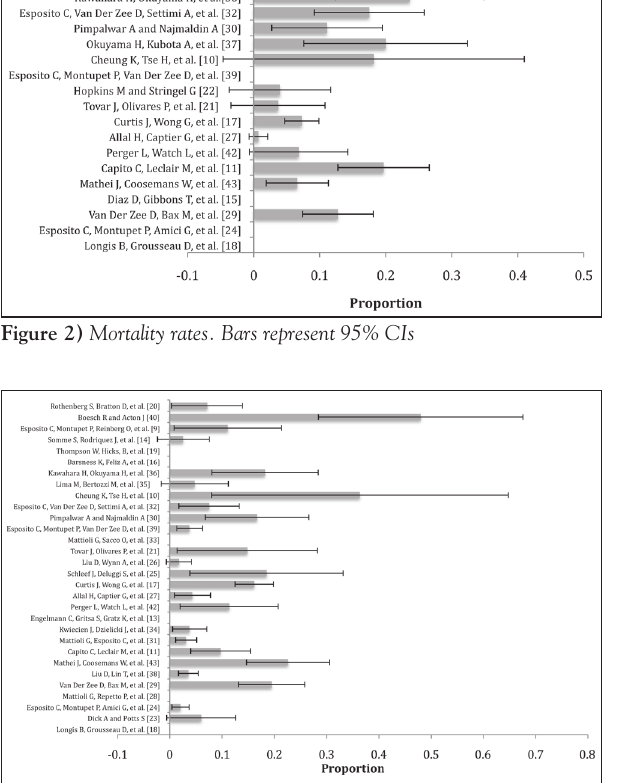
Figure 3) Recurrence rates. Bars represent 95% CIs